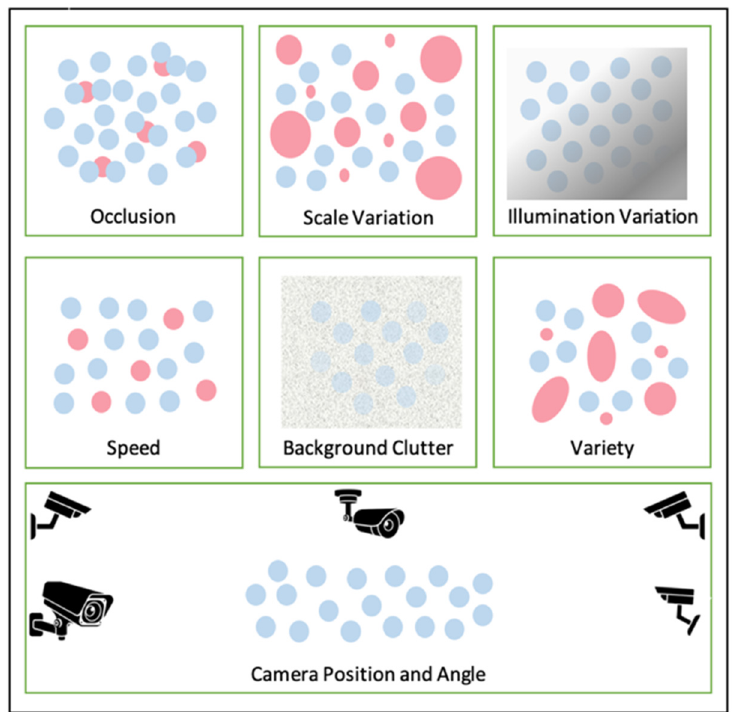
Figure 3. Crowd scene analysis challenges.